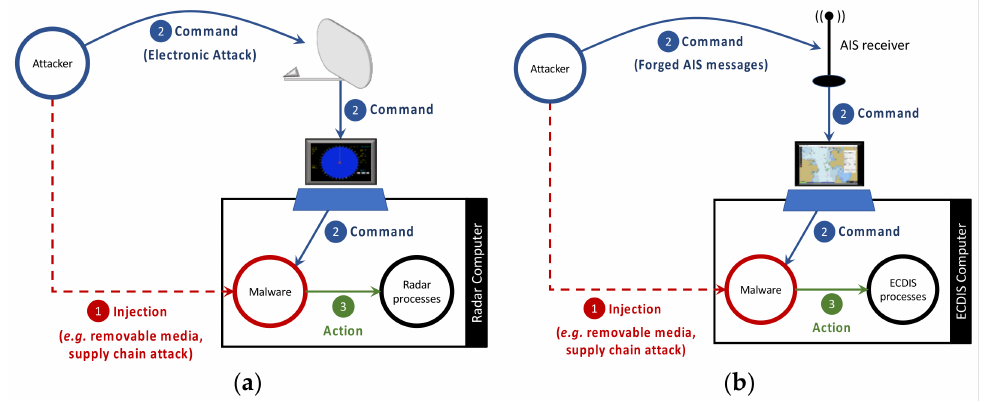
Figure 1. Attack model in: ( a ) a radar system; ( b ) an AIS/ECDIS